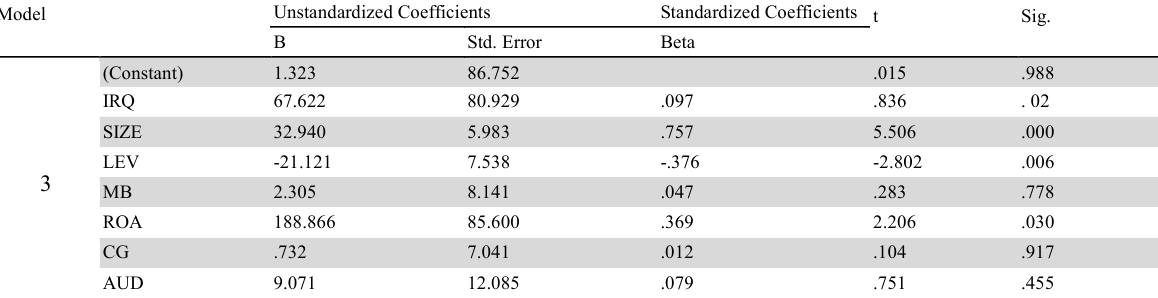
The results of regression analysis between DQIBR and Share Price Model Unstandardized Coefficients Standardized Coefficients t